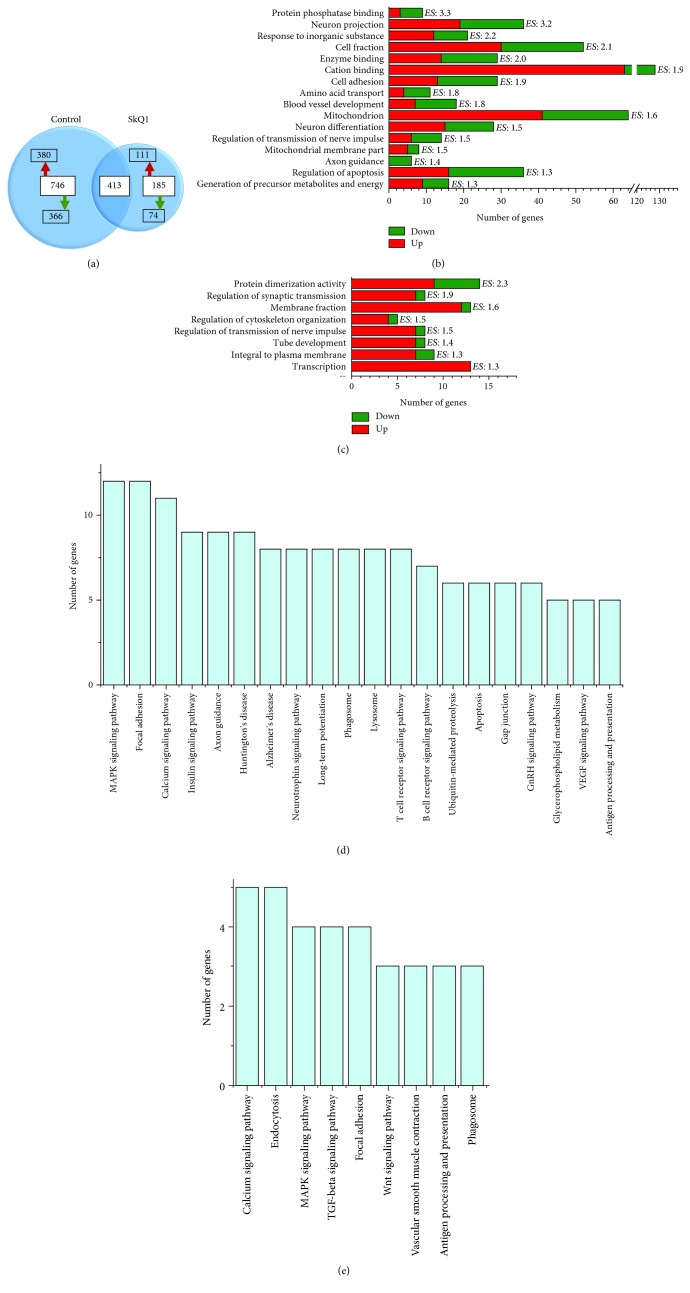
Gene distribution and enrichment analysis of 18-month-old untreated OXYS rats and OXYS rats treated with SkQ1. (a) An area-proportional Venn diagram, summarizing gene identifiers in the overlap (413 genes) between untreated and SkQ1-treated OXYS rats. The analysis of gene distribution points to specific changes in the expression of 746 genes in untreated OXYS rats, 380 of which are upregulated (red arrow) and 366 downregulated (green arrow). OXYS rats treated with SkQ1 showed specific changes in the expression of 185 genes, 111 of which were upregulated (red arrow) and 74 downregulated (green arrow). DAVID cluster analysis performed on DEGs exclusively expressed in the hippocampus of (b) untreated and (c) SkQ1-treated OXYS rats identified the most statistically significant upregulated and downregulated biological processes. The significance of each gene cluster is evaluated through the enrichment score (ES). An ES >1.3 is equivalent to a nonlog scale value of 0.05. The pathway analysis by KEGG for DEGs was exclusively expressed in the hippocampus of (d) untreated and (e) SkQ1-treated OXYS rats.